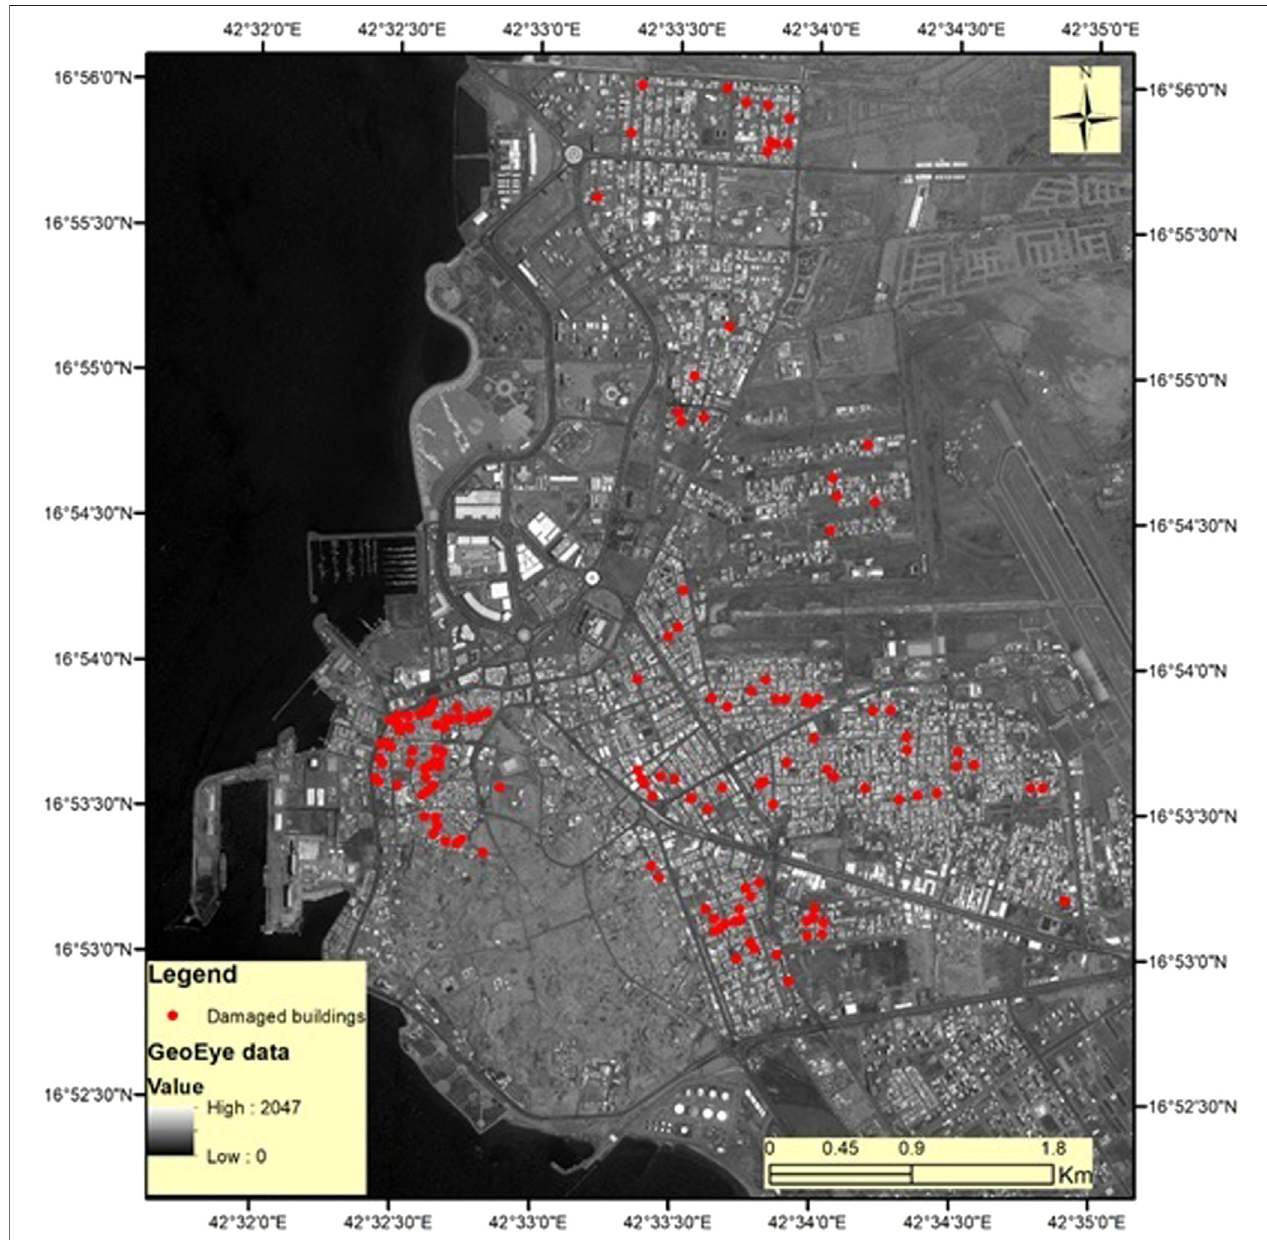
FIGURE 11 | GeoEye-1 image with 0.41 m resolution showing the damaged buildings in Jizan based on the fi eld survey.